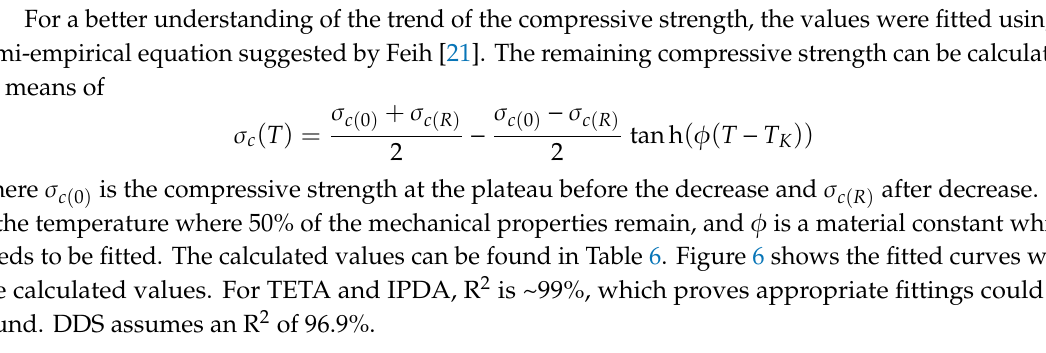
Table 6. Parameters calculated for the fitting function suggested by